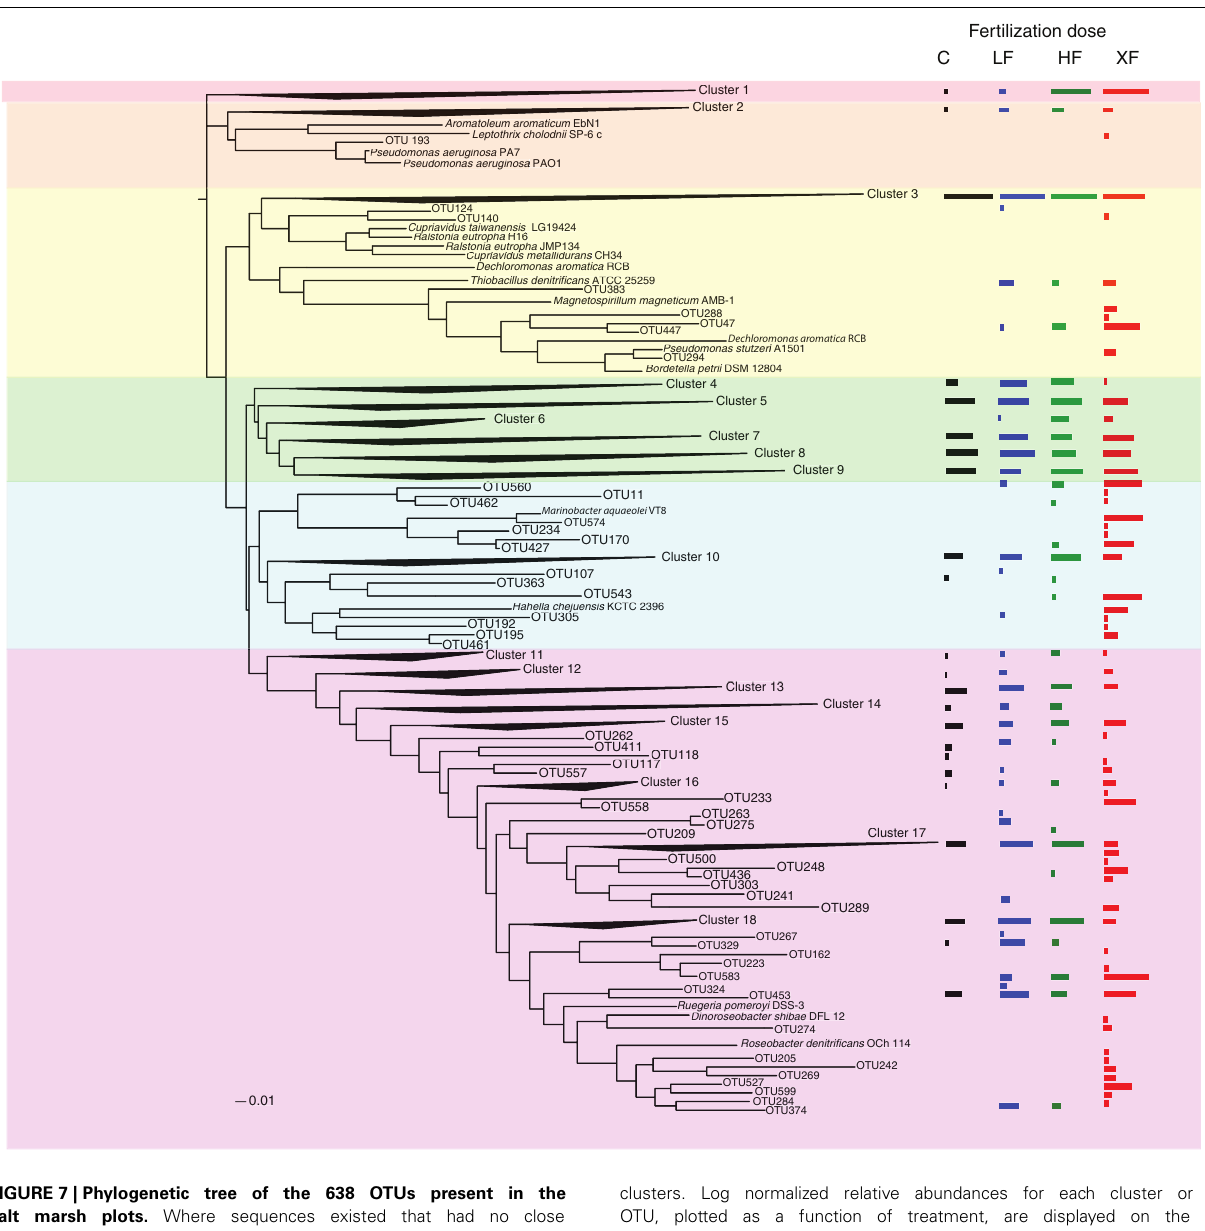
clusters. Log normalized relative abundances for each cluster or OTU, plotted as a function of treatment, are displayed on the right of the